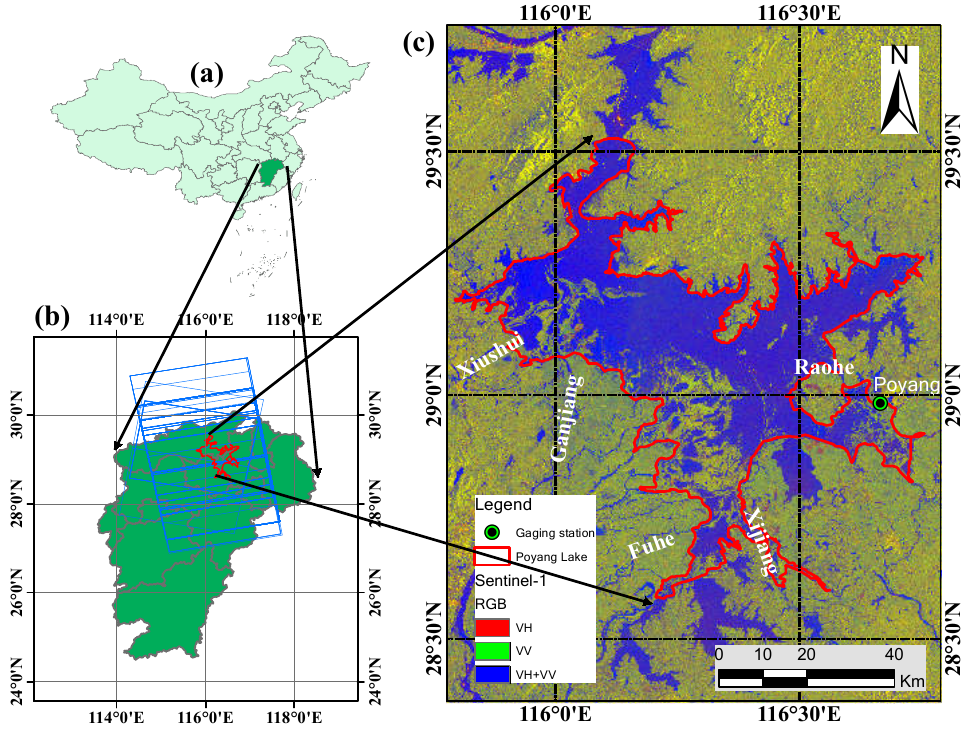
Figure 1. Spatial location and extent of the study area of Poyang Lake in Jiangxi Province, People’s Republic of China. ( a ) shows the administrative divisions of China, the green polygon in ( b ) shows Jiangxi Province, and ( c ) shows Poyang Lake. The blue polygons in ( b ) show the swaths of Sentinel-1 SAR data and the red polygon in ( c ) shows the study area.